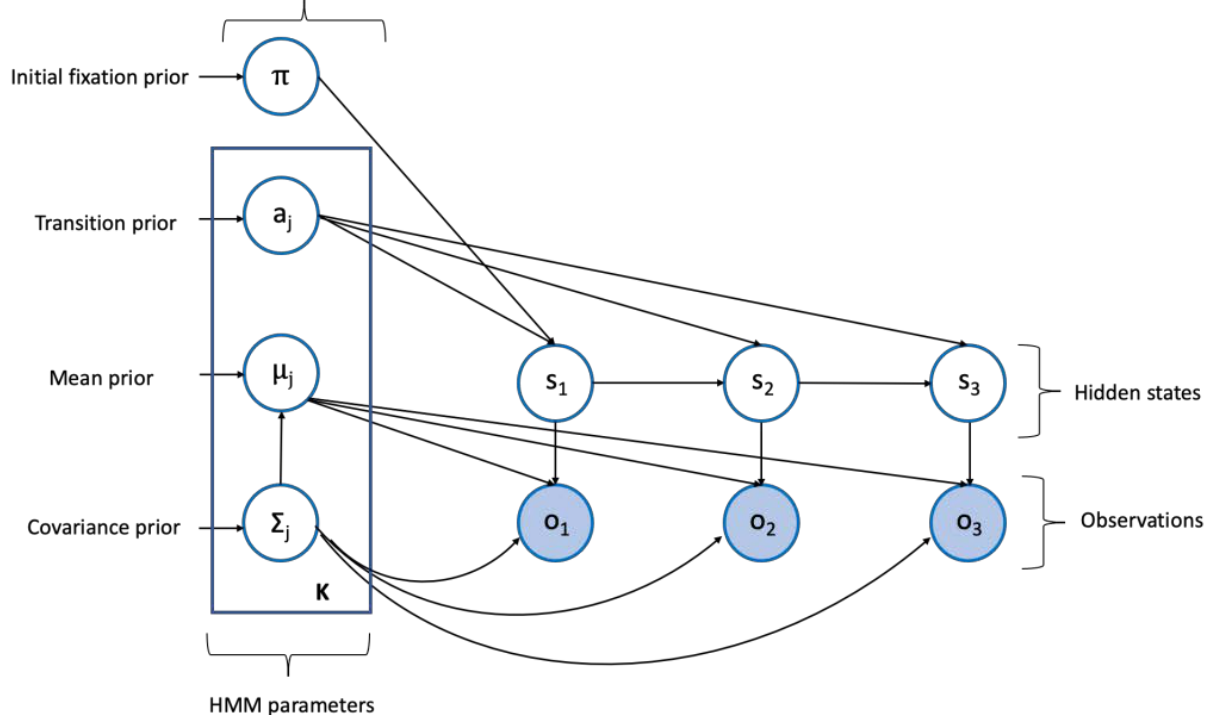
Figure 2. Structure and parameters of an HMM. The O n indicates the observed fixation data; The S n represents the hidden states. The prior distributions of the HMM parameters were presented on the left where K is the number of the hidden states.